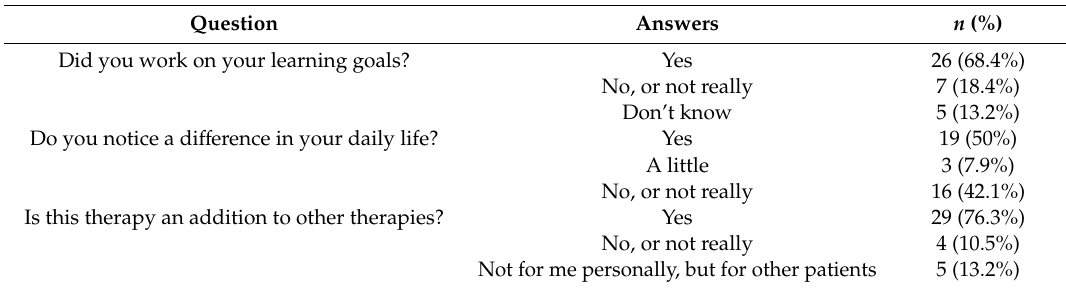
Table 4. Answers to interview questions for participants of the VRAPT condition who completed the therapy at follow-up ( N =